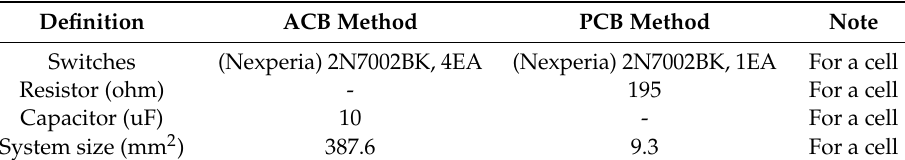
Table 9. Component specifications used in the experiment for the ACB and PCB methods.